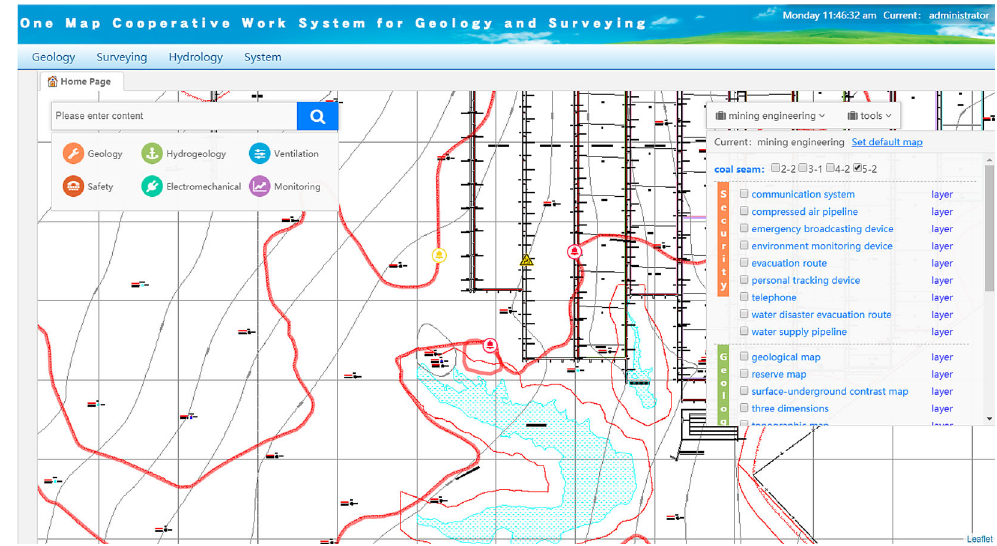
Fig. 2 A snapshot from the ‘‘One Map’’ collaborative management system